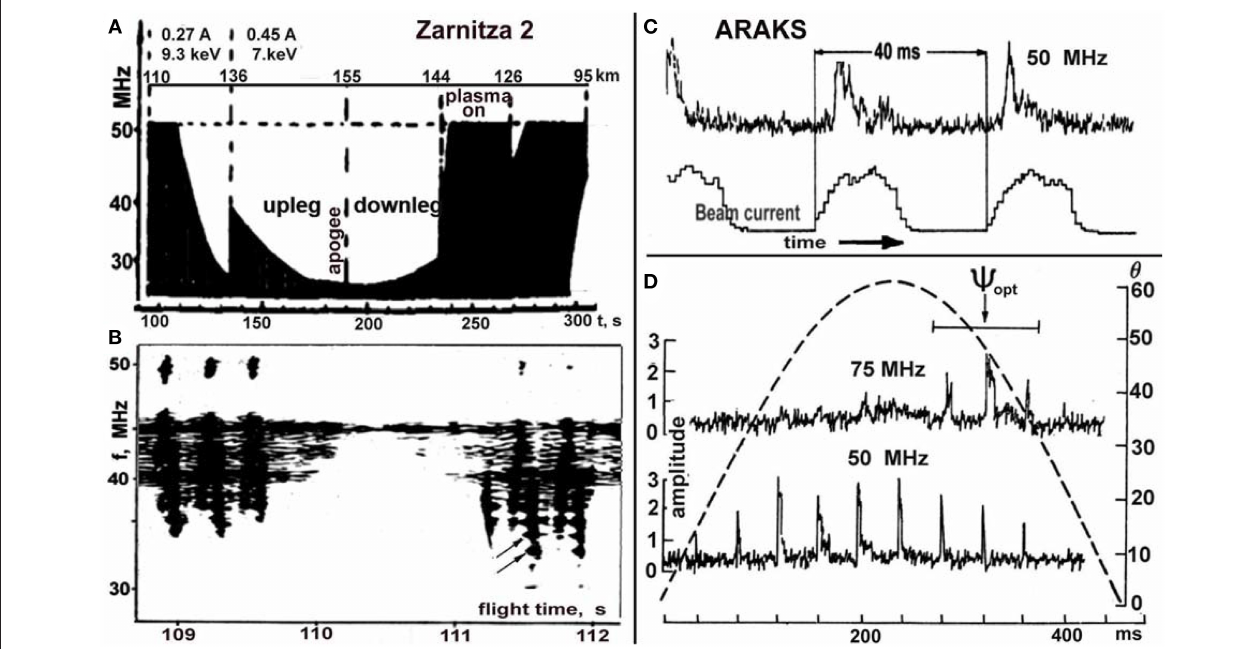
FIGURE 7 | VHF radioemission in Zarnitza 2 and ARAKS: Variation of the broadband spectrum in Zarnitza 2 with (A) altitude and (B) the rocket’s spin (one long pulse per 2 revolutions). Arrows indicate the specral maxima at ( s 1 / 2) f ce . Adapted from Dokukin et al. (1981). (C) Delay of radioemission at 50 MHz relative to the start of + 20 ms pulses in ARAKS and (D) dependence of radioemission at 75 MHz on the phase of the rocket’s rotation. The dashed curve shows the beam pitch angle θ 0 . After Mishin and Ruzhin (1980b). Reprinted by permission from